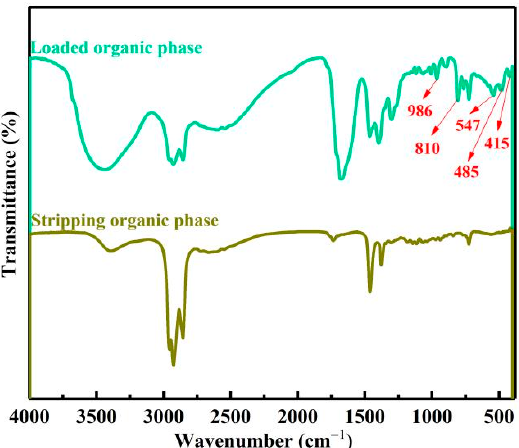
Figure 15. The FTIR of loaded organic phase and lean organic phase.